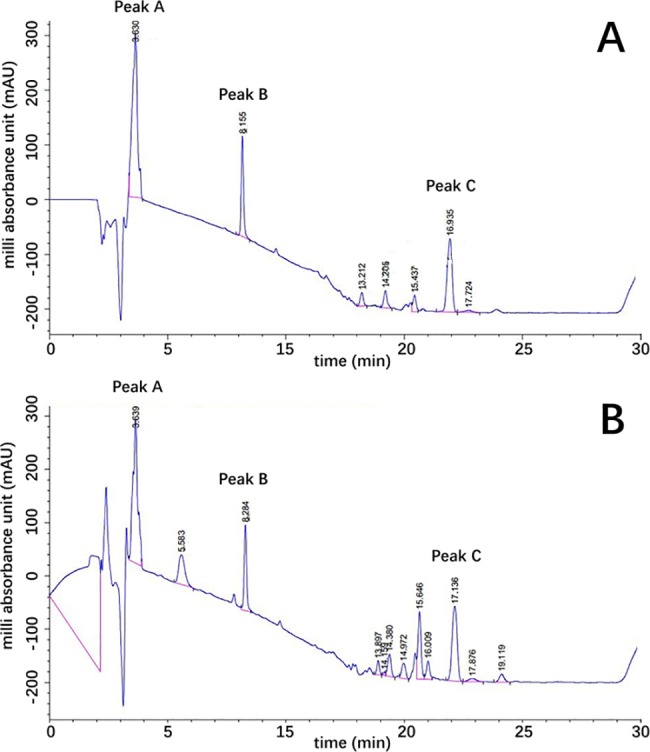
High-performance liquid chromatography (HPLC) results of (A) commercial surfactin sample, and (B) our extract surfactin of B. subtilis HH2 in LB medium. There were three main peaks (Peak A-C) of the extract and the surfactin standard in the same location.